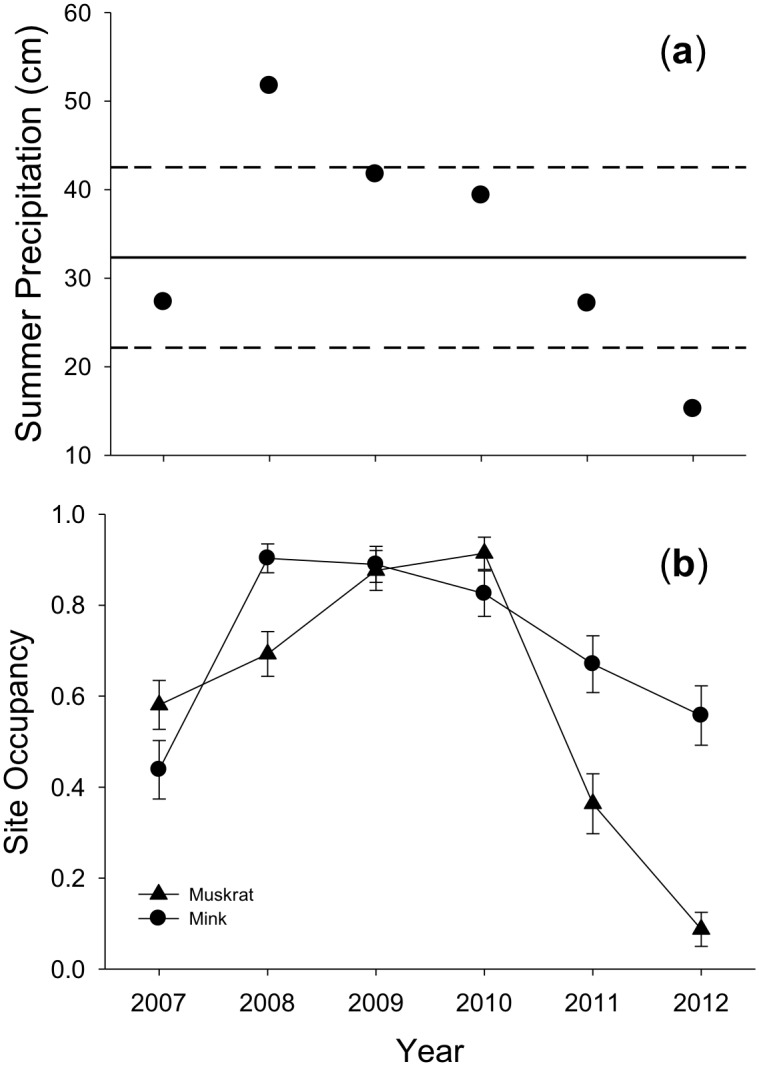
Trends in (a) summer precipitation and (b) site occupancy dynamics of mink (Neovison vison) and muskrats (Ondatra zibethicus) in Illinois, USA from 2007–2012.Summer precipitation (sum of May, June, and July) for each year is compared to the 123-year mean (solid line) ± 1 SD (dashed line) for the same period. Estimates of site occupancy (± 1 SE) are model-averaged and corrected for imperfect detection.